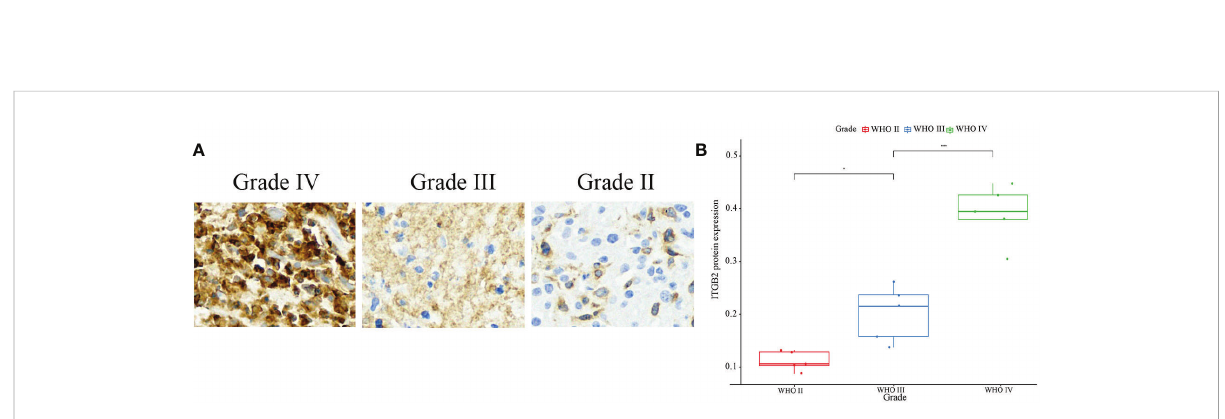
FIGURE 2 IHC staining of ITGB2. (A) IHC staining of ITGB2 in different grade, ×20. (B) Protein expression of ITGB2 in different grades of glioma(mean density,IOD SUM/area). *p < 0.05, ****p <